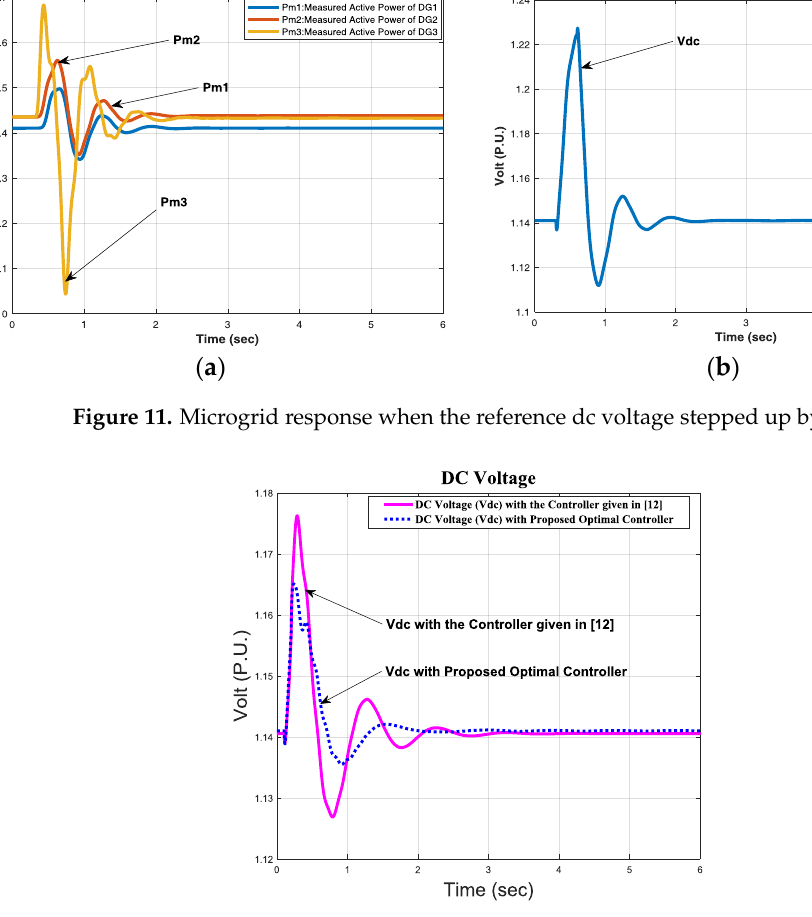
Figure 12. Comparison of DC voltage responses of the active load when a fault occurred at CPL bus. Table 1. System parameters.